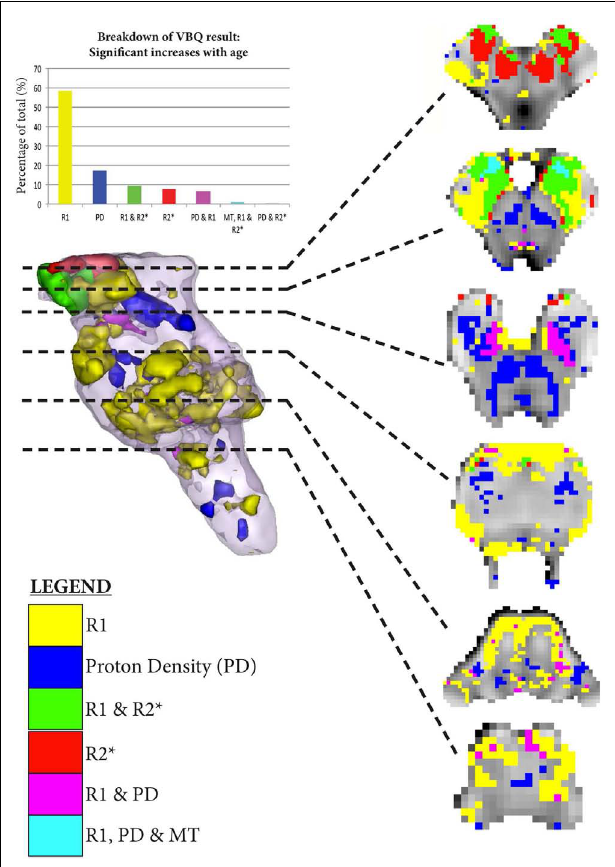
FIGURE 7 | Significant regional increases binarized at p < 0.001 uncorrected .The legend classifies the regions of significant increase across the MPM, allowing overlapping significant increases to be simultaneously visualized.The histogram takes the total number of all significant voxels shown in the rendering, and then classifies them according to the MPMs in which those voxels are found in as per the